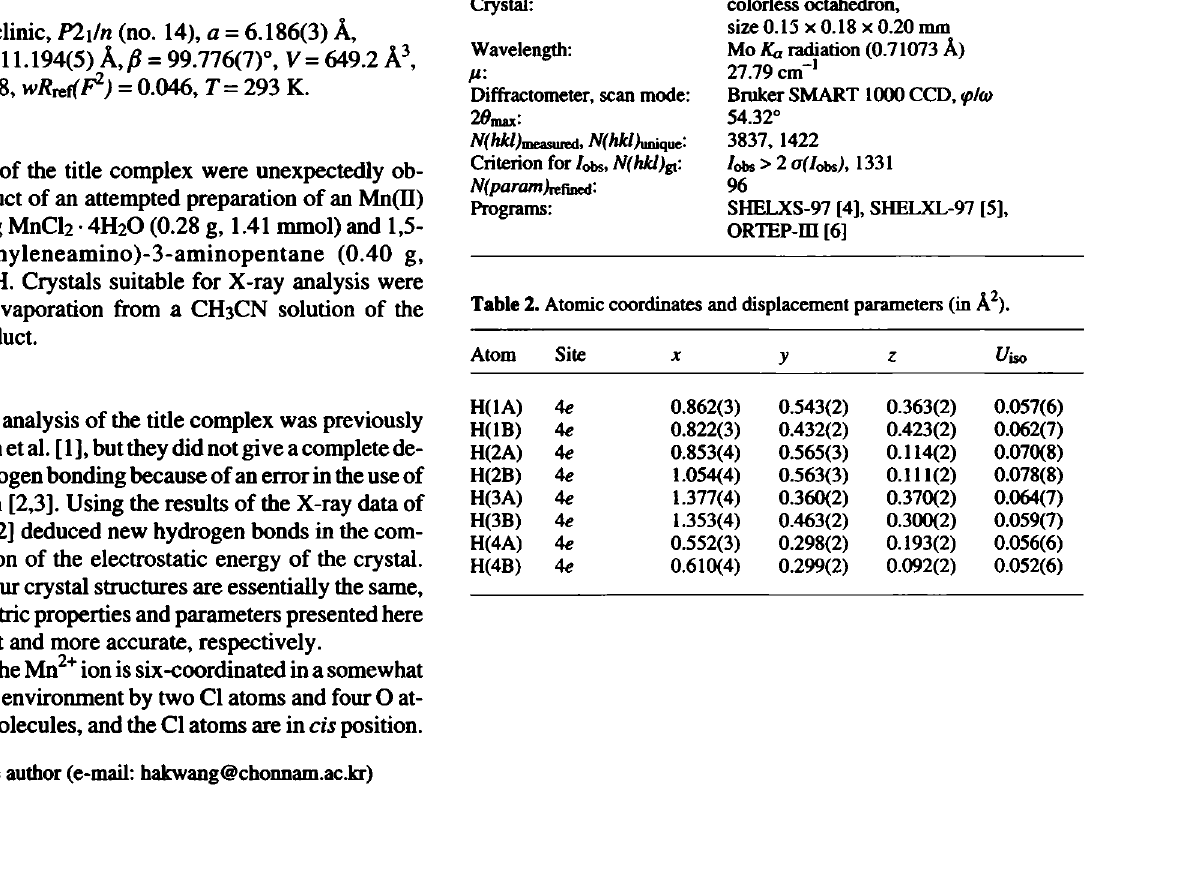
Table 1. Data collection and handling.